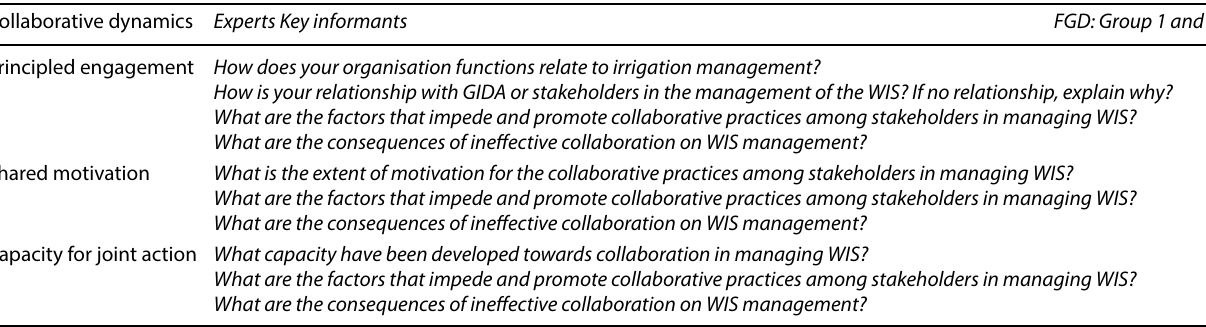
Table 2 List of sample guiding questions used in the study Collaborative dynamics Experts Key informants